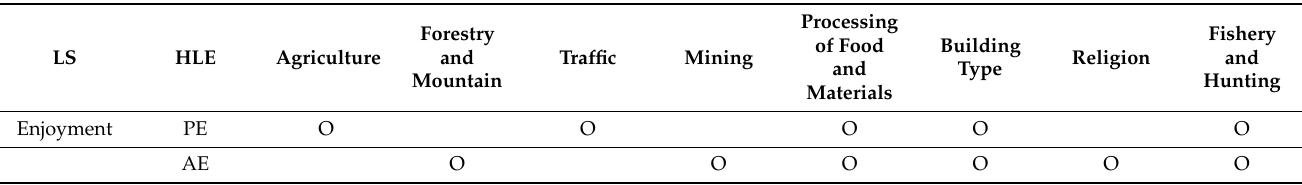
Table 2. Enjoyment of LS&HLE in Gaotiankeng